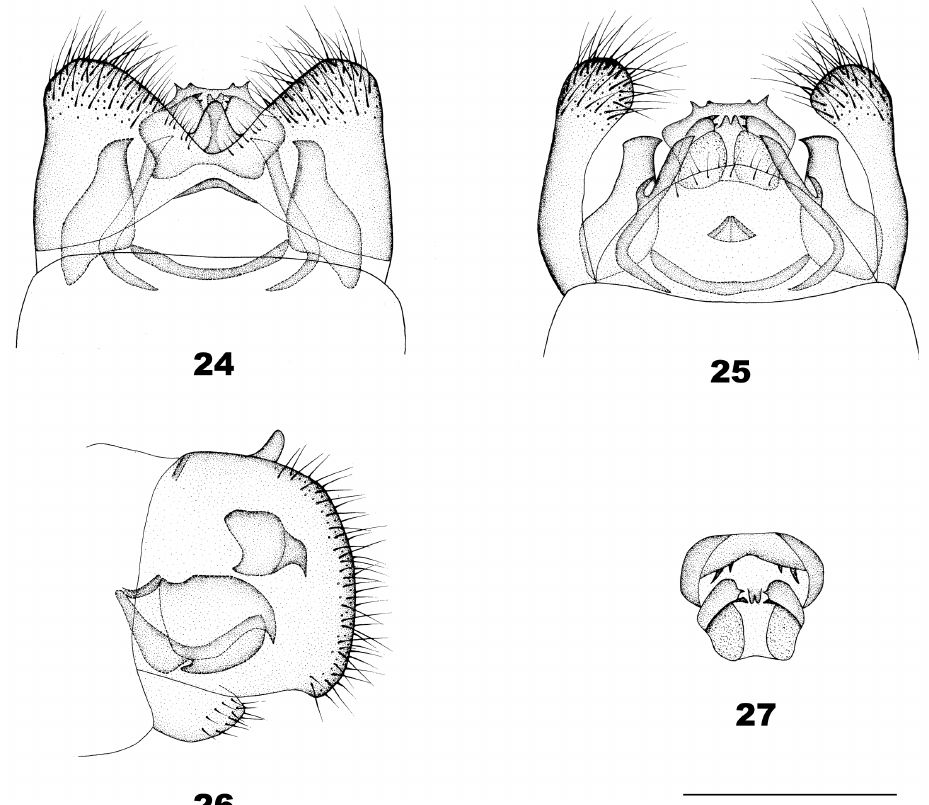
view; 27. Male ectoproct, caudal view. Scale bars: 0.5 mm.